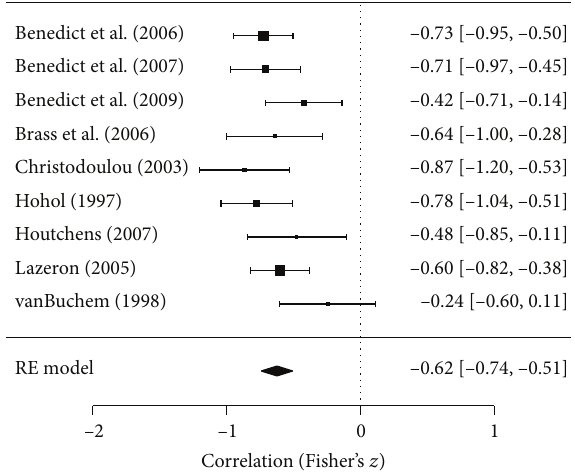
Figure 3: Correlation between brain atrophy and SDMT processing speed in patients with mixed MS